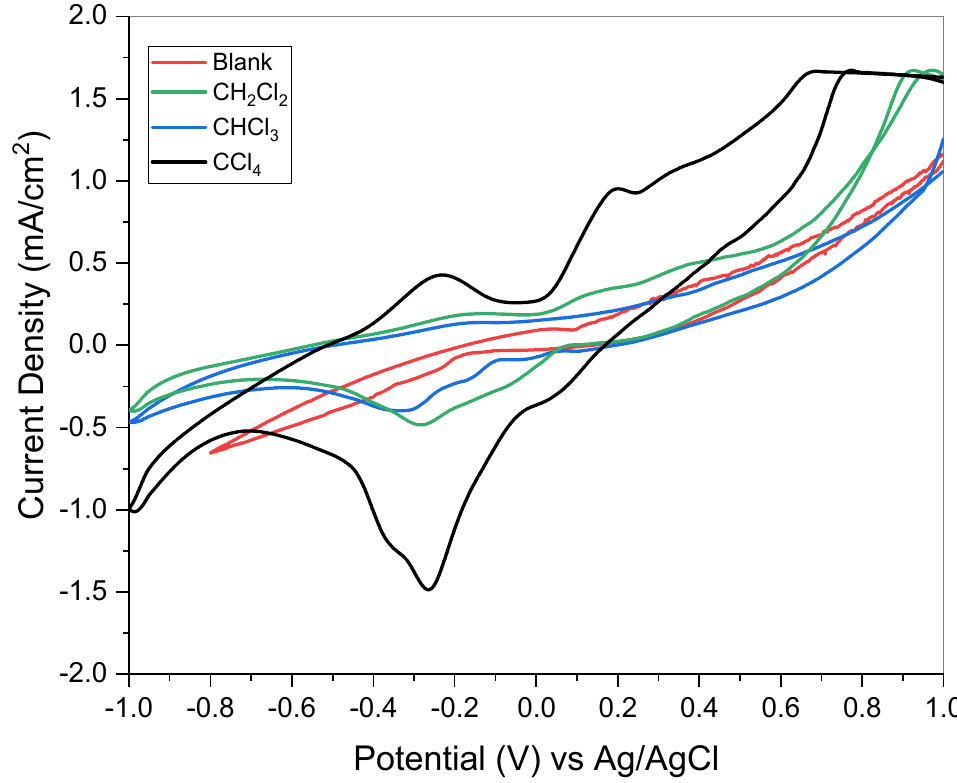
Figure 1. Cyclic voltammetry scan for the Co-MoS 2 -GF cathode in the absence (blank background electrolytes, 0.5 M of Na 2 SO 4 ) and presence of 5 mM of each of the CCl 4 , CHCl 3 , and CH 2 Cl 2. Scan rate, 10 mV/s.